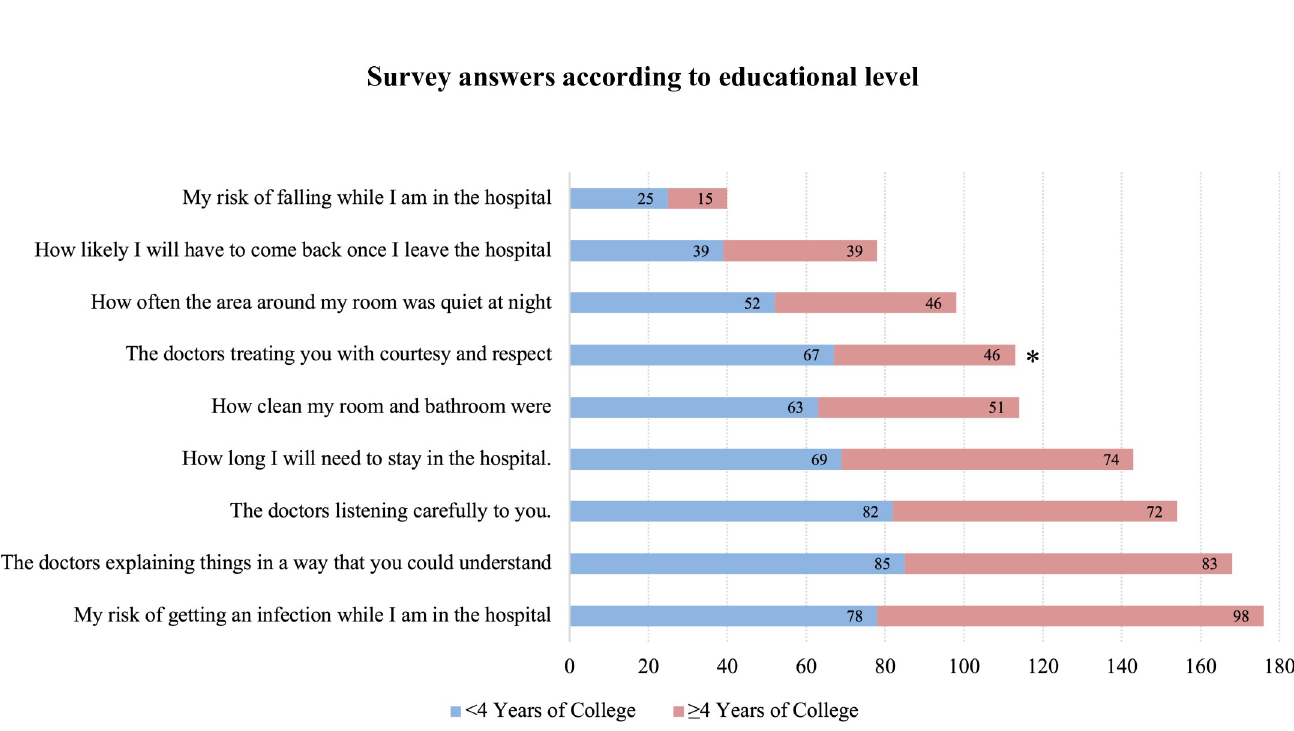
Fig 4. Survey answers according to educational level. Frequency of participants that answered each question as “Very Important” in the hospital care, according to educational level. � Statistically significant.